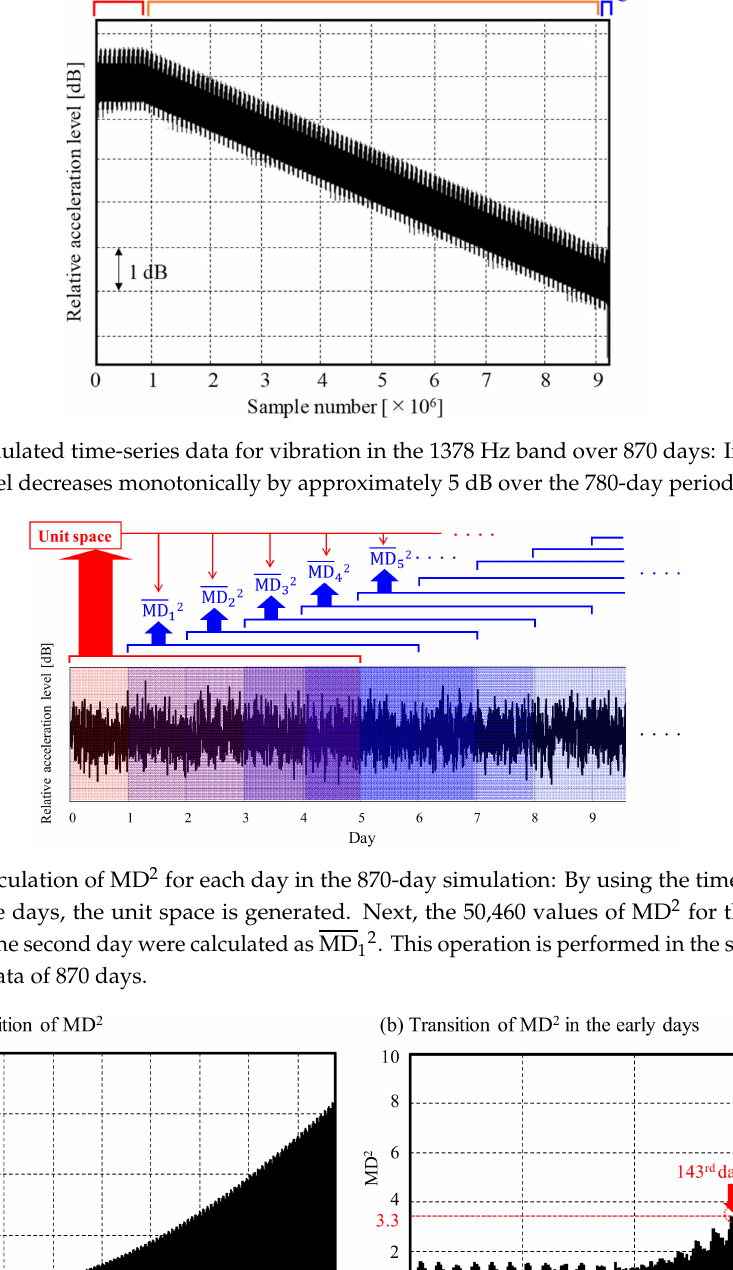
2 changes as the energy